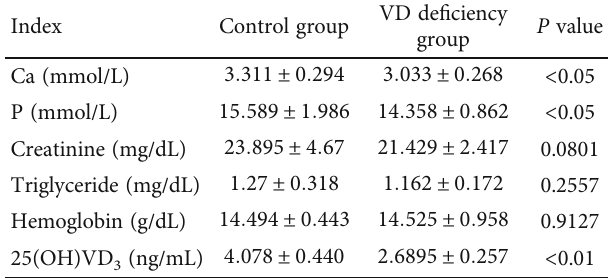
Table 1: Primer sequence. Gene